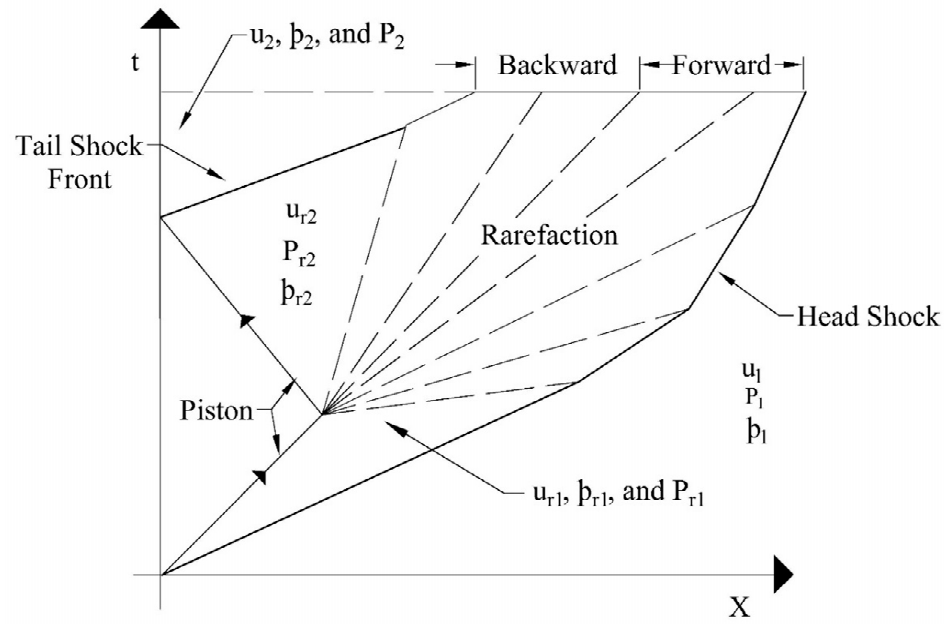
Figure 4. Decaying of N-wave [Adopted based on a figure in Courant, (1948)].